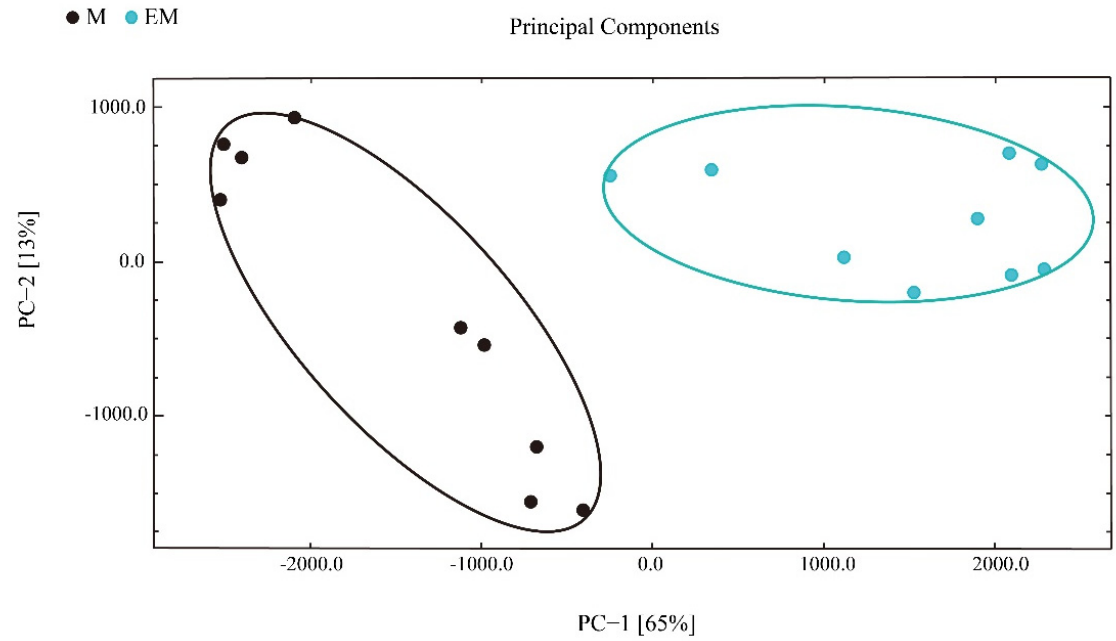
Figure 5. Gallery plot of selected volatile organic compounds in the gas-phase ion migration spec- trum. Note: Regions A and B represent the characteristic peak areas of the M and EM group, respec- tively.